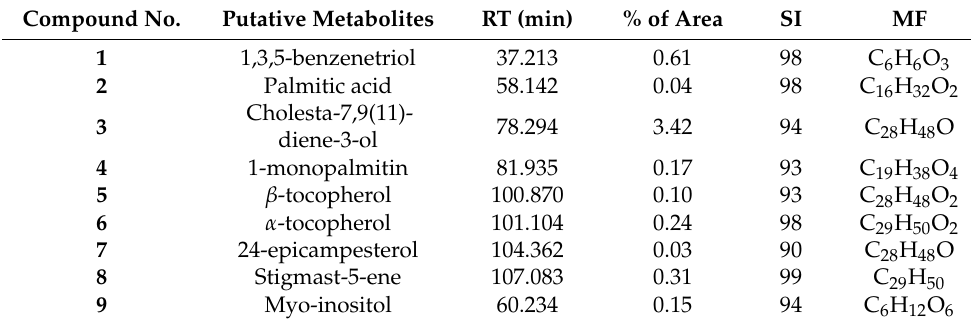
Figure 4. GC-MS chromatogram of the methanol extract of P. malayana leaves. Labelled peaks: 1 -1,3,5-benzenetriol, 2 -palmitic acid, 3 -cholesta-7,9(11)-diene-3-ol, 4 -1-monopalmitin, 5 - β -tocopherol, 6 - α -tocopherol, 7 -24-epicampesterol, 8 -stigmast-5-ene, and 9 -myo-inositol. The fragment m / z spectra of all compounds were compared to the NIST 14 database with similarity index above 90%. Table 2. Putative metabolites detected by GC-MS